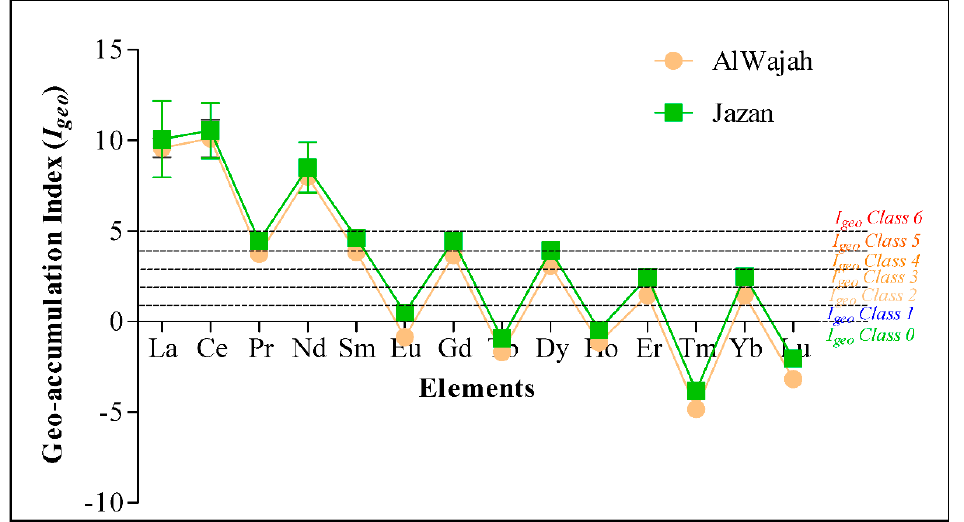
Figure 3. Geo-accumulation index of rare earth elements at Al Wajah and Jazan mangrove ecosystems. Values are mean ± standard error.